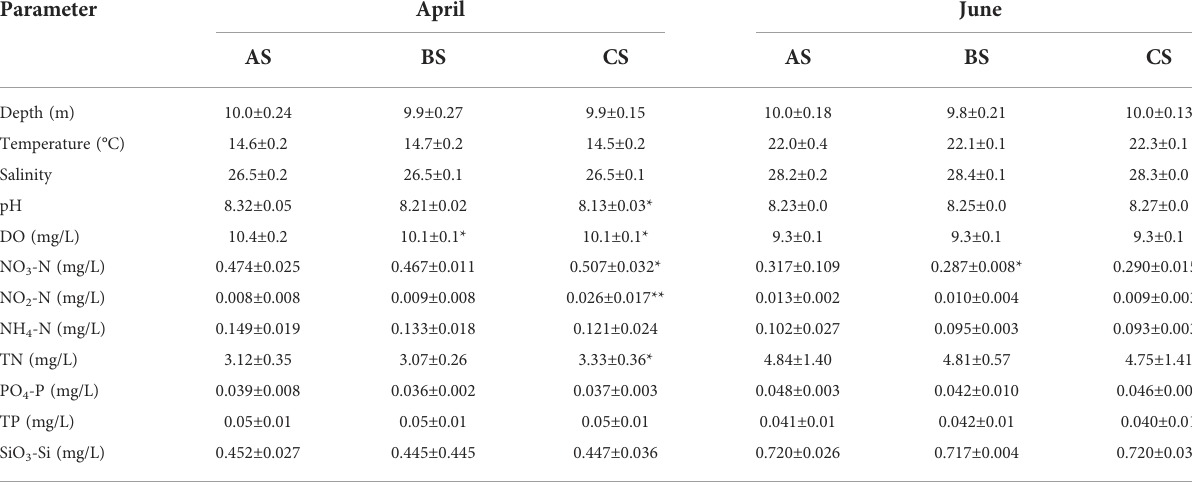
TABLE 1 Temporal and spatial variation in environmental parameters of waters measured in